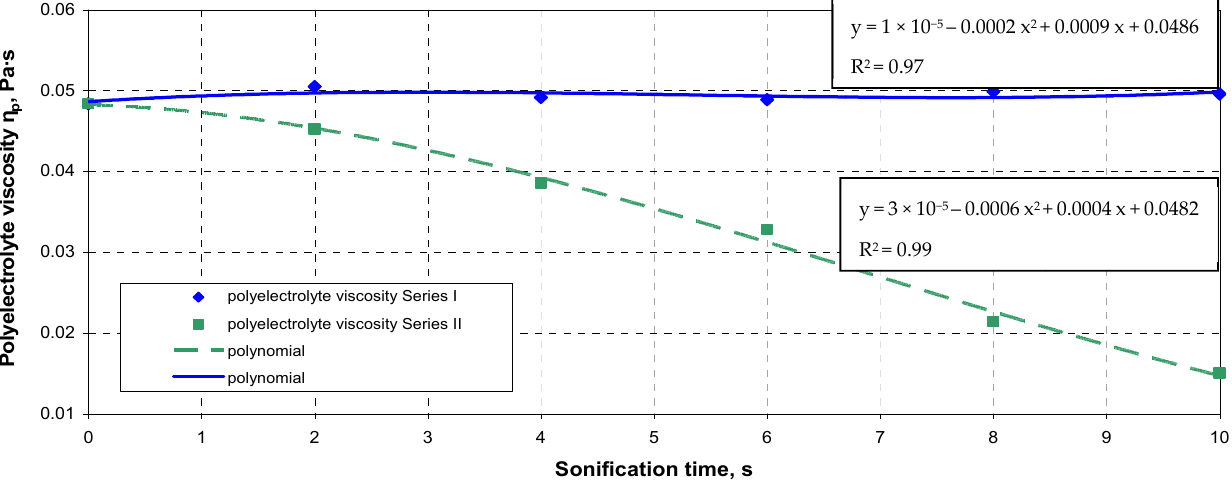
Figure 2. Dependence of viscosity and microstructure of tested polyelectrolyte Renfloc 25489 on its sonication time. Photographs of the sonicated polyelectrolyte (Series I—A = 8 µm and Series II—A = 16 µm): time 0, 2, 6, 10 s, respectively.